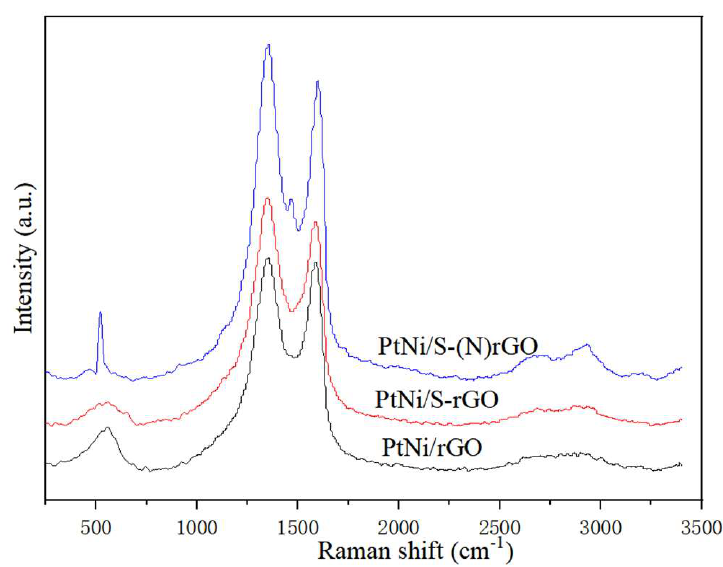
− (N)rGO, PtNi/S − rGO, and PtNi/rGO. Figure 3. The normalized Raman spectra of PtNi/S−(N)rGO, PtNi/S−rGO, and PtNi/rGO. Figure 3. The normalized Raman spectra of PtNi/S The surface properties of PtNi/rGO, PtNi/S-rGO, and PtNi/S-(N)rGO were char- acterized by the zeta potential analyzer. It was shown that the zeta surface potential of PtNi/rGO was 4.5 ± 1 mV, which demonstrated the reduction of GO by eliminating the epoxy and hydroxyl groups on the C atom of graphene. The value of potential of PtNi/S- rGO and PtNi/S-(N)rGO shifted to the − 50 ± 2 and − 55 ± 2 mV, respectively. The surface properties of catalyst were changed by formation of the sulfonated groups instead of the protons of